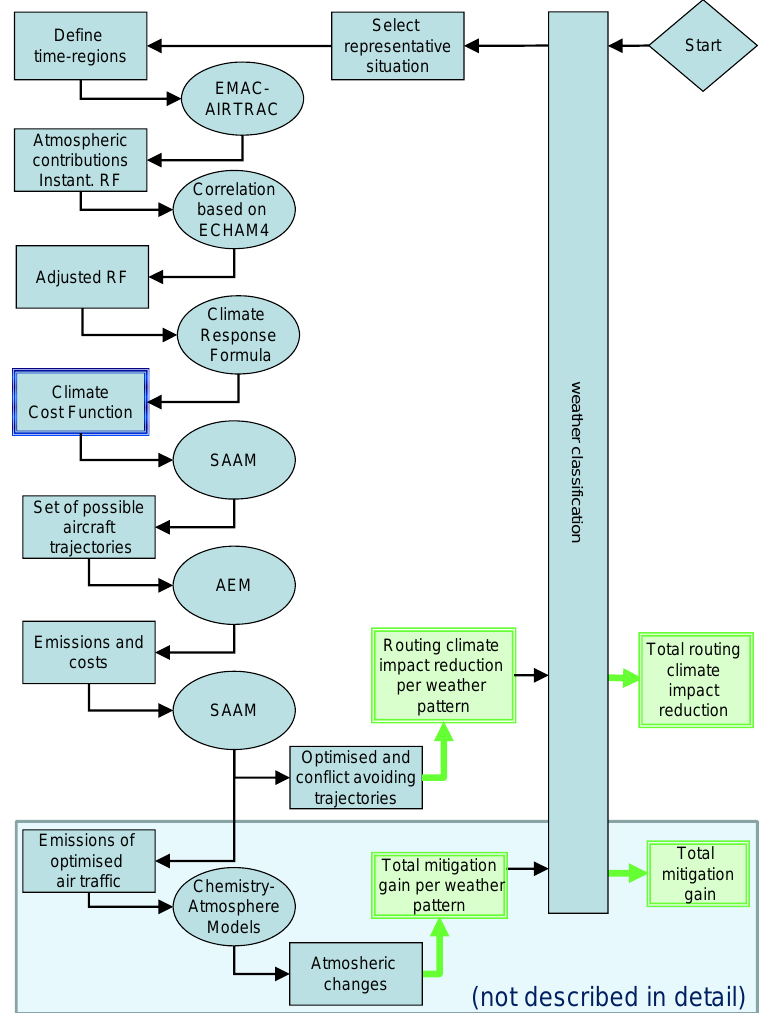
Fig. 1. Illustration of the model chain. Models are given in the ovals. Data and definitions are given in rectangles. Climate cost functions are highlighted (dark blue), as are major results (green). The light-blue box at the bottom indicates a possible extension of the modelling chain, which is not covered